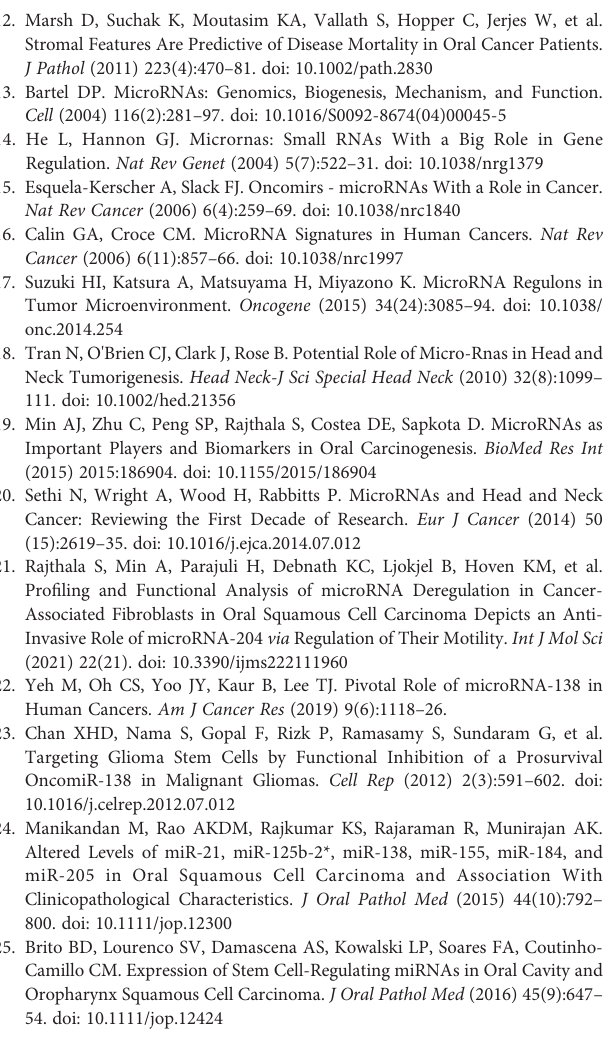
Supplementary Table S1 | Patient history and tumour characteristics of OSCC cohort. Supplementary Table S2 | List of Taqman Assays (ThermoFisher, USA). Supplementary Table S3 | List of antibodies used in western